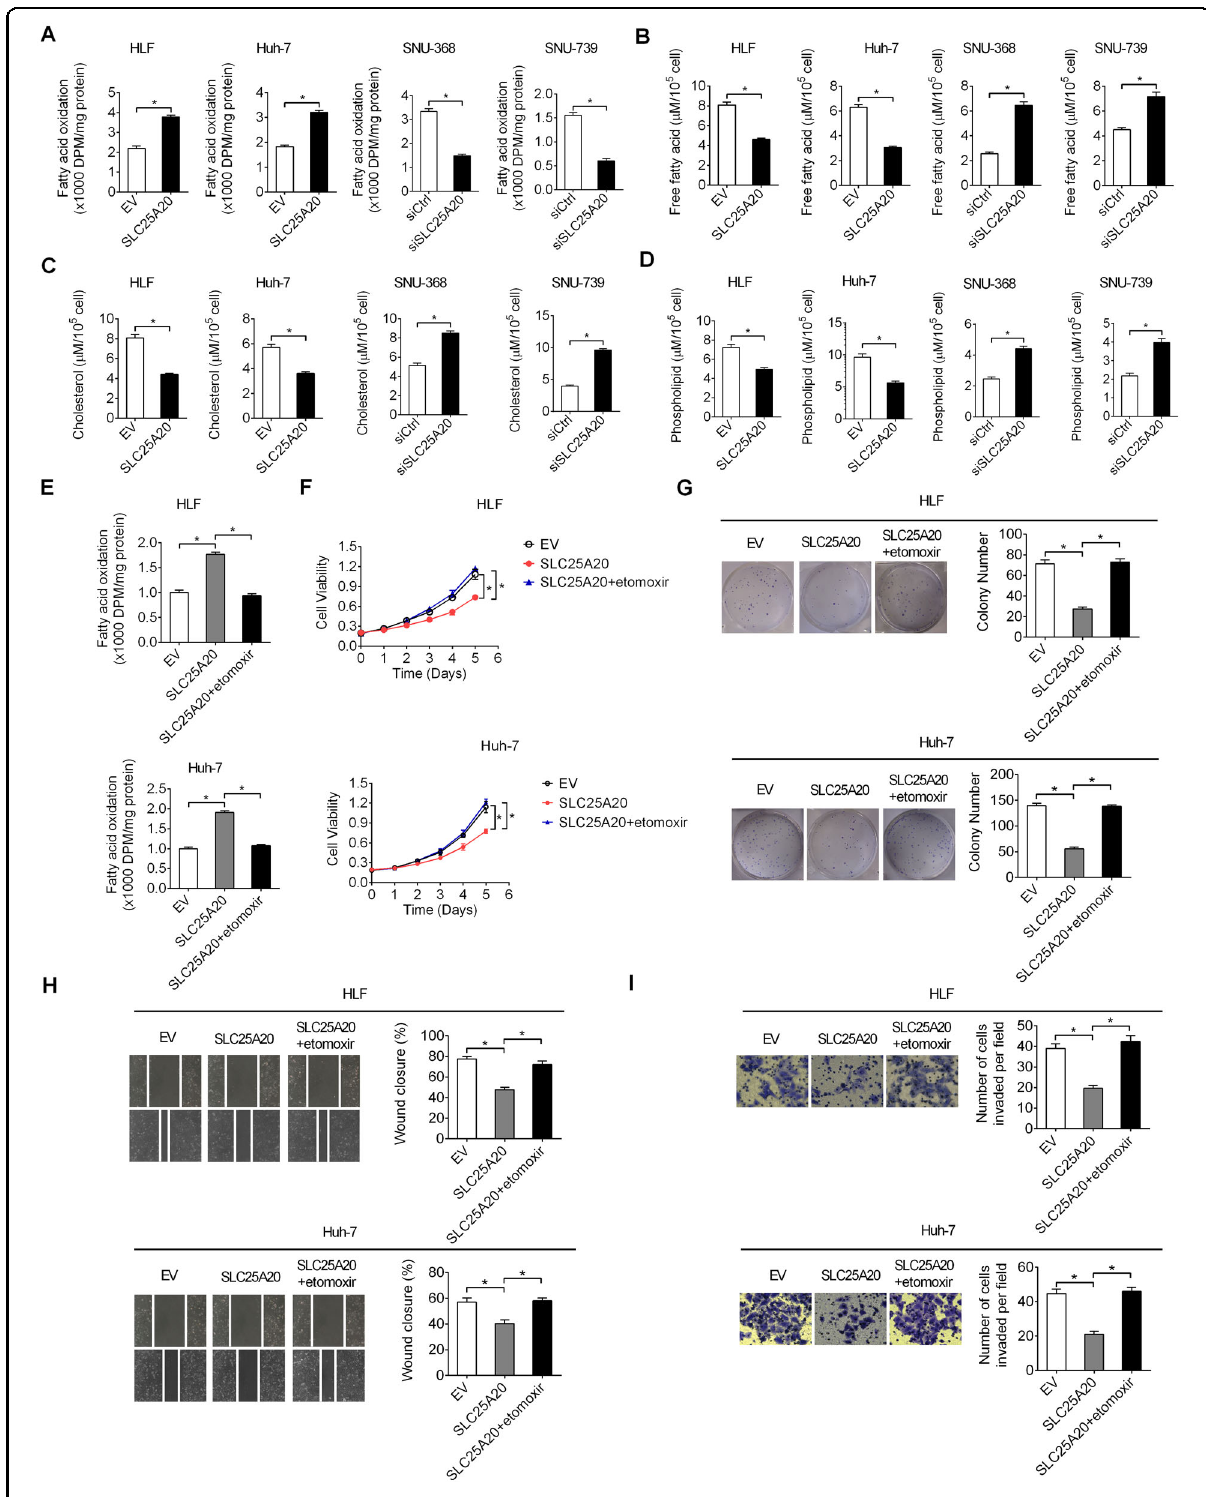
Fig. 6 SLC25A20 down-regulation promoted HCC growth and metastasis through suppression of fatty-acid oxidation. A 3 H-labeled oleic acid was used to access the ability of fatty-acid oxidation in HCC cells with treatment as indicated. B , D Intracellular levels of free fatty acid (FFA), triglyceride (TAG), and phospholipids (PL) were determined in HCC cells with treatment as indicated. E Fatty-acid oxidation was determined in HCC cells with treatment as indicated. F , G Cell growth ability was determined by MTS cell viability and colony formation assays in HCC cells with treatment as indicated. H , I Cell metastasis was determined by wound-healing and matrigel-invasion assays in HCC cells with treatment as